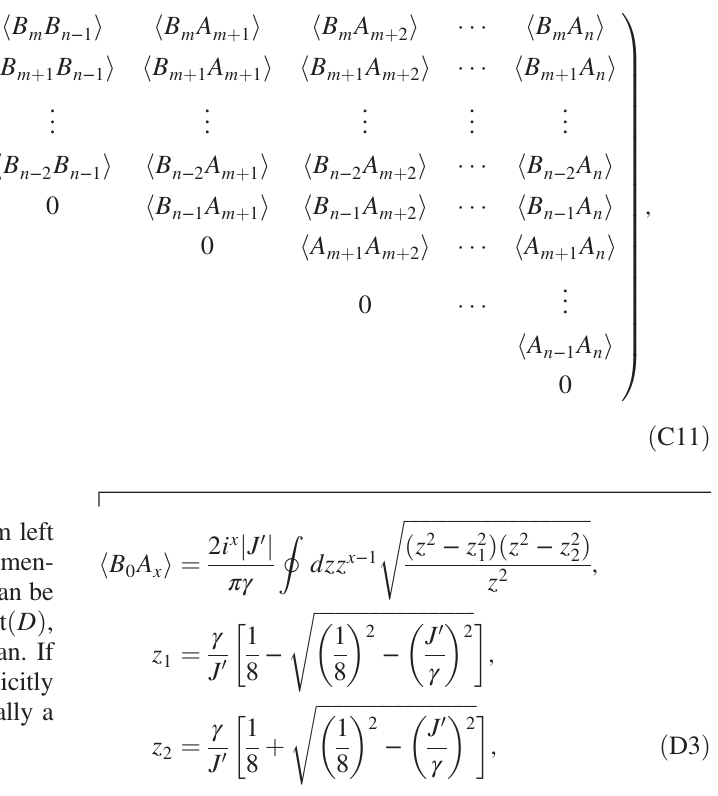
where the contour is along the unit circle [solid line in Fig. 10(a)] and the integral is real. The branch points are along the real axis because we have defined z ¼ ie ik . The branch cuts are along several segments of the real axis [jagged lines in Fig. 10(a)]. The branch cuts are chosen so that the integrand is continuous along the contour. We then deform the contour to lines between − z 1 and z 1 [dashed line in Fig. 10(a)]. Making a further change of variable